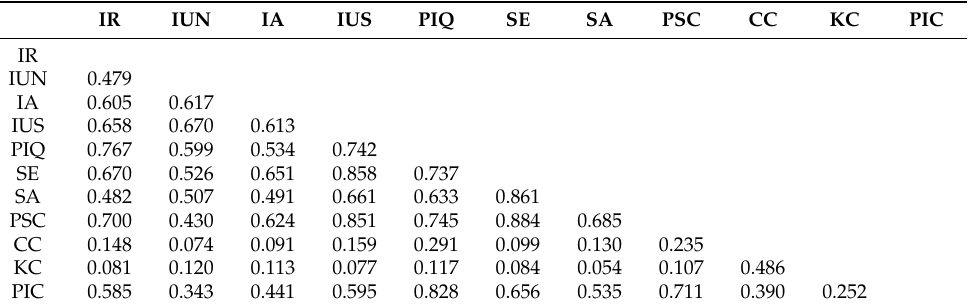
Table 6. Value of the heterotrait-monotrait